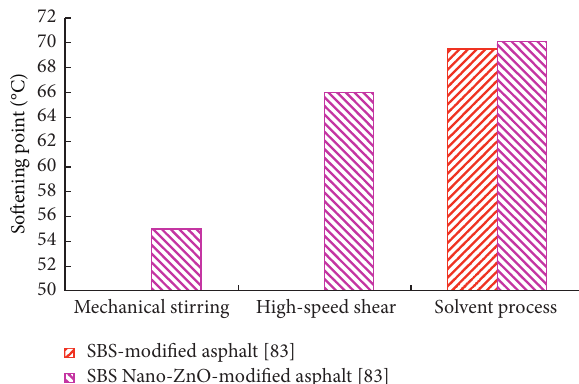
Figure 25: Softening point of different preparation method.